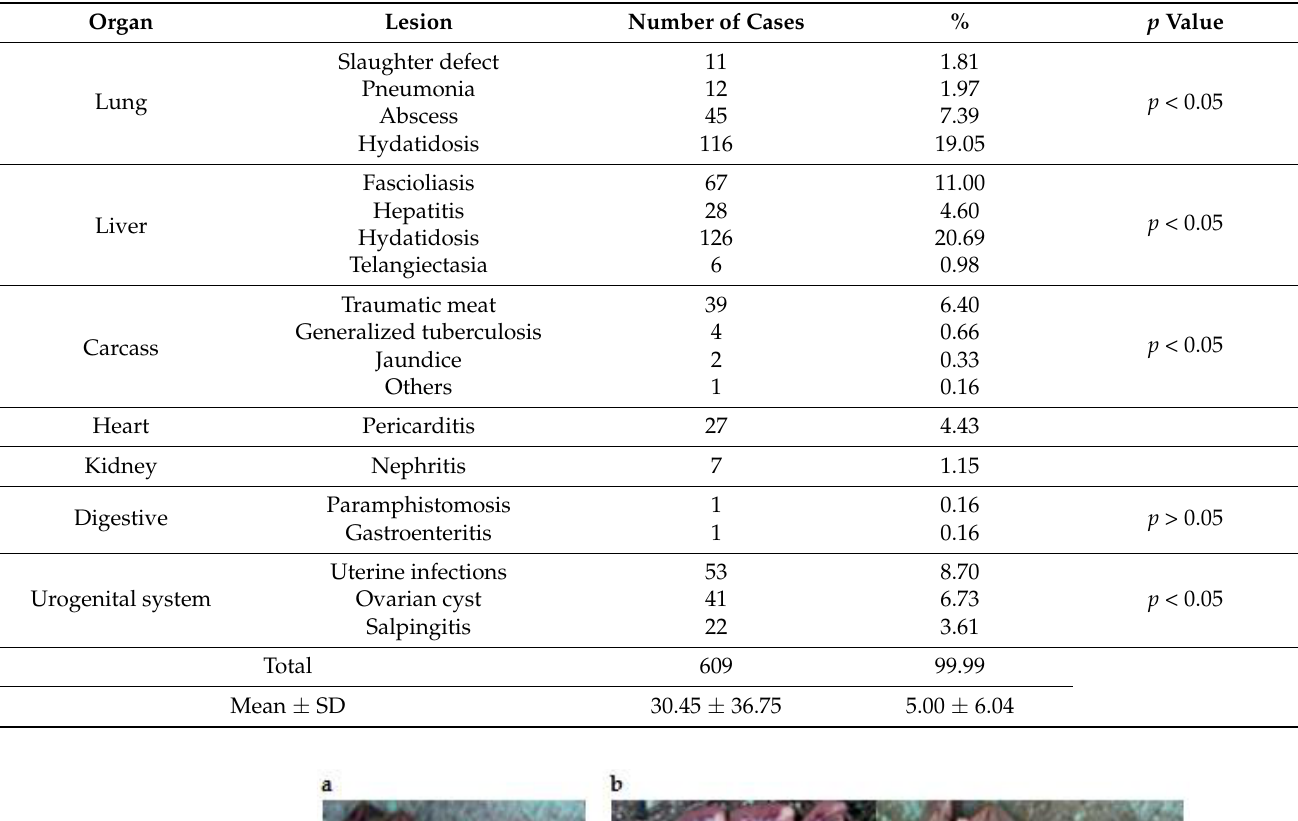
Table 2. Distribution of lesions according to the organs affected.